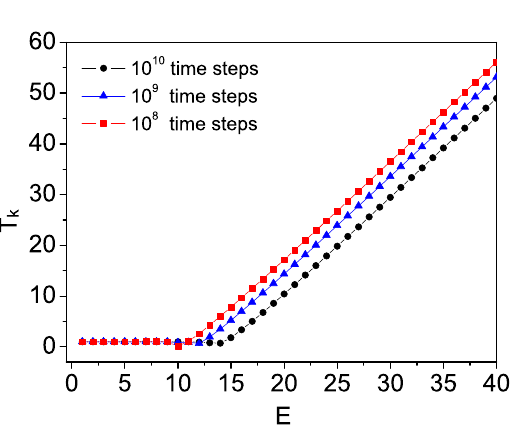
Figure 1. Kinetic temperature T k and the quantity P k as a function of the total energy E of the isolated log- oscillator for different ε . In our simulation, τ = 1, relaxation time and average time are 10 8 and 2 × 10 9 time steps, respectively. Numerical fitting gives T k = 2( E − E c ) for the linearly increasing part. Inset: Enlarged view of low-energy part within the green rectangle.